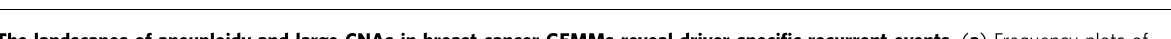
Figure 4 | The landscapes of aneuploidy and large CNAs in breast cancer GEMMs reveal driver-specific recurrent events. ( a ) Frequency plots of chromosomal aberrations in each of the 11 GEMMs analysed, showing that each GEMM has a characteristic landscape of aneuploidy and large CNAs. Gains are shown in red, losses in blue. The 15 statistically significant driver-specific CNAs (adjusted P o 0.05; w 2 -test) are highlighted with black asterisks. ( b ) Frequency plots of chromosomal aberrations in lymphomas and in prostate tumours induced by Myc activation, showing that trisomy 15 recurs in Myc -induced tumours in various tissues, whereas other events (for example, monosomy 13 in lymphomas) are tissue dependent. Significant CNAs (adjusted P o 0.05; w 2 -test) are highlighted with brown asterisks. ( c ) Frequency plots of chromosomal aberrations in prostate tumours induced by SV40Tag, showing that trisomy X, and potentially monosomies 7 and 19, recur in SV40Tag-induced tumours independent of the tissue type, whereas other events (for example, trisomies 3 and 18 in breast tumours) are tissue dependent. Significant CNAs (adjusted P o 0.05; w 2 -test) are highlighted with brown asterisks. ( d ) Comparative oncogenomics can narrow regions of interest within recurrent CNAs in both species. Presented is a synteny analysis of three driver-specific CNAs: mouse chromosomes are shown in the centre, and syntenic human chromosomes surround them. Synteny blocks ( 4 300kb; small gaps filled) are color coded. Significantly, enriched CNAs in human tumours that activate the same pathway (as judged by gene expression signatures 33 ) are marked with a red line to the side of the human chromosome. The synteny blocks that correspond to recurrent events in both species are marked with red asterisks. For example, trisomy 15 recurs in Myc -induced mouse breast cancer; as 8q amplification recurs in human tumours with high MYC expression signature, but only a telomere-bound part of 8q is syntenic to mouse chromosome 15, the region of interest within human chromosome 8q can be thus considerably narrowed ( B 50% reduction in size). Of note, MYC itself is located within this syntenic region. See also Supplementary Figs